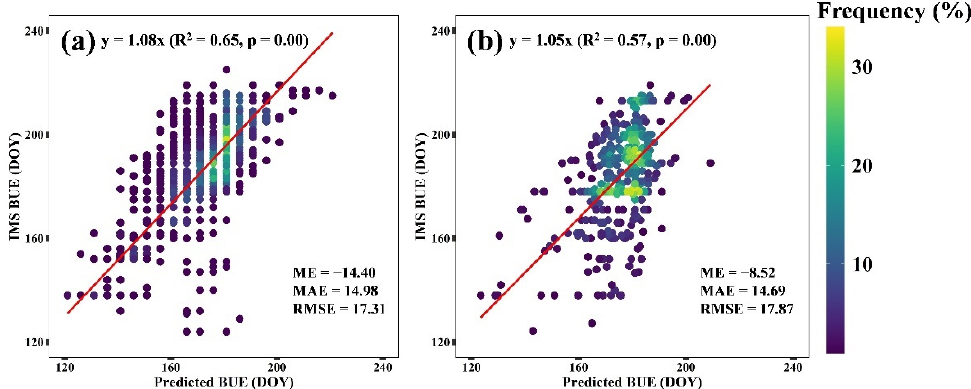
Figure 6. Density plots showing the relationships between the predicted and RDims BUE dates using pixel ( a ) and lake ( b ) as the statistical unit. The red line represents the linear fit with the intercept forced to 0.